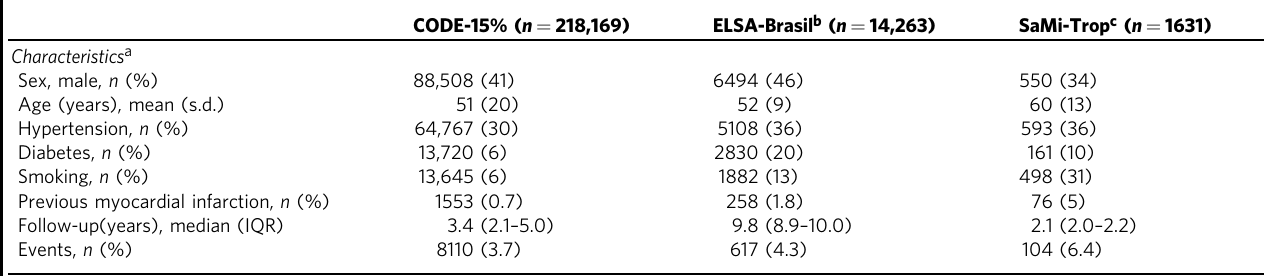
Table 1 Baseline characteristics.